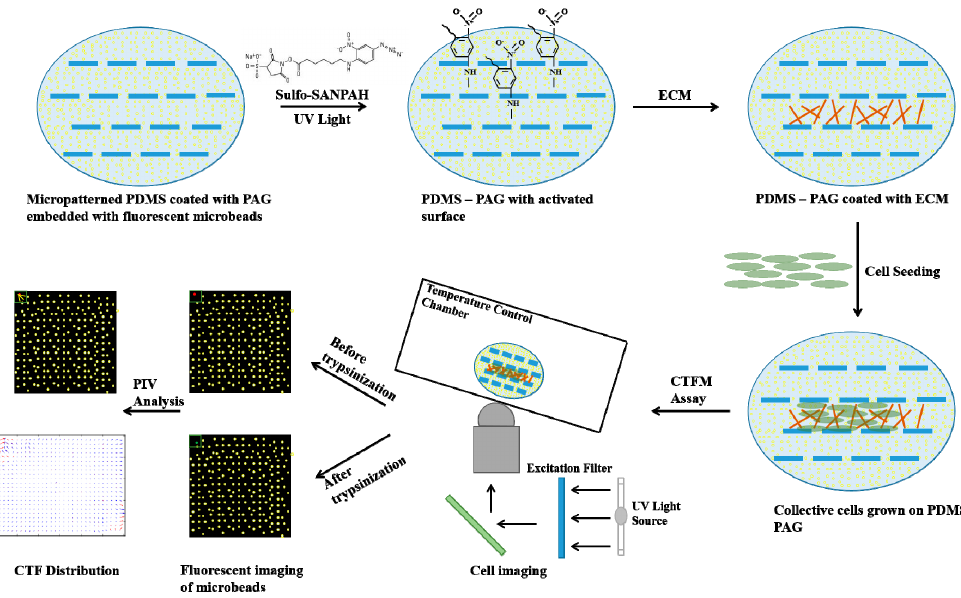
Figure 3. The schematic illustration for the making of PDMS microchannels with a polyacrylamide gel (PAG) coating for cell traction force microscopy measurement (Top views). The micropatterned PDMS is coated with PAG embedded with a thin layer of fluorescent microbeads. A UV-activated heterobifunctional cross linker, sulfo-SANPAH, is applied for ECM coupling. Cells are then seeded onto the activated surface for further study with cell traction force microscopy. After obtaining a pair of fluorescent images of the same frame before and after trypsinization, the deformation of the elastic substrate is determined and used for the CTF computation.